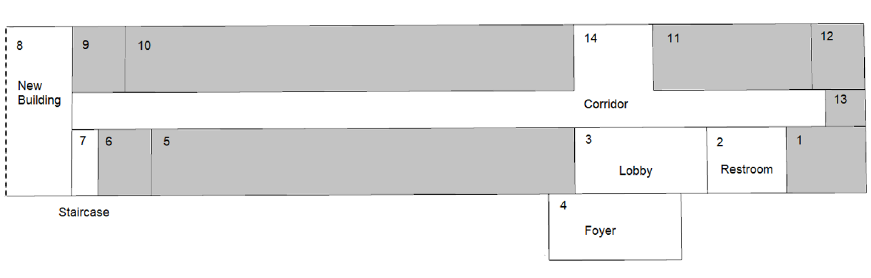
Figure 3. Thermal zones plan on the ground floor. Numbers indicate each thermal